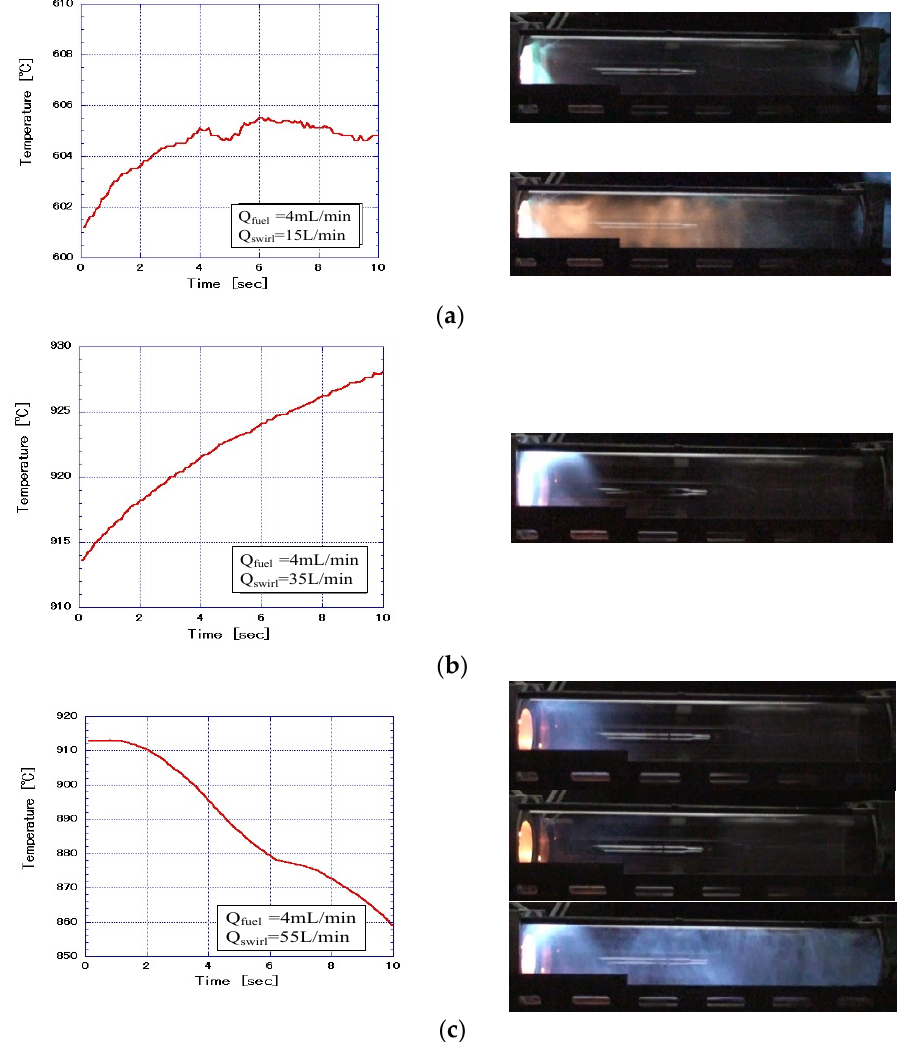
Figure 11. Temperature fluctuation in the combustion chamber (Q fuel = 4 mL/min fixed). ( a ) Q swirl = 15 L/min. ( b ) Q swirl = 35 L/min. ( c ) Q swirl = 55 L/min.